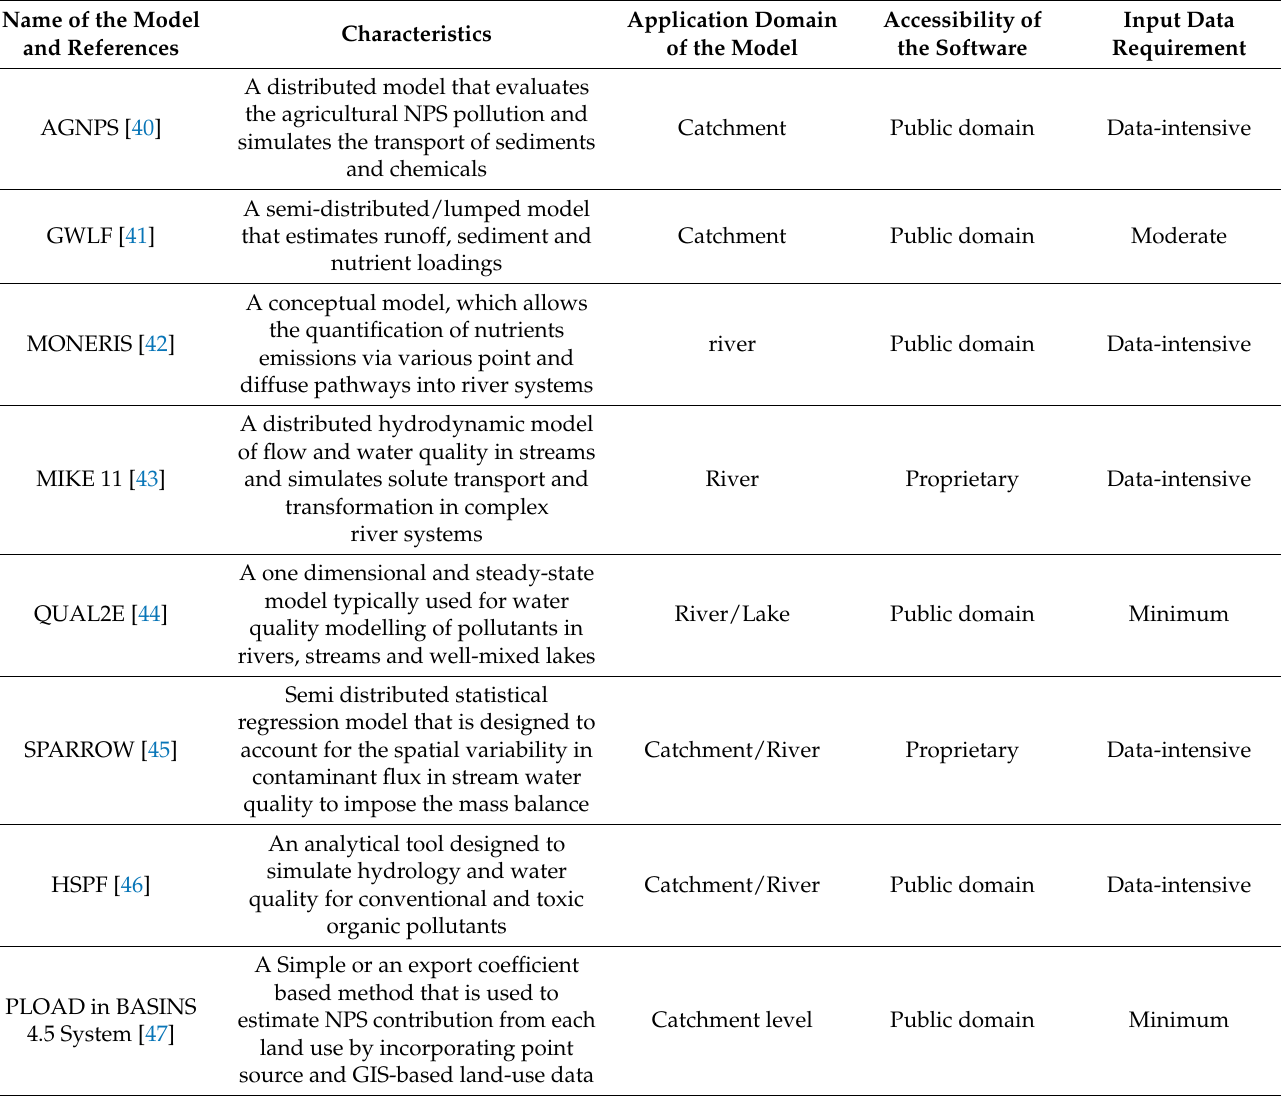
Table 5. Some selected modelling tools and their selection criteria